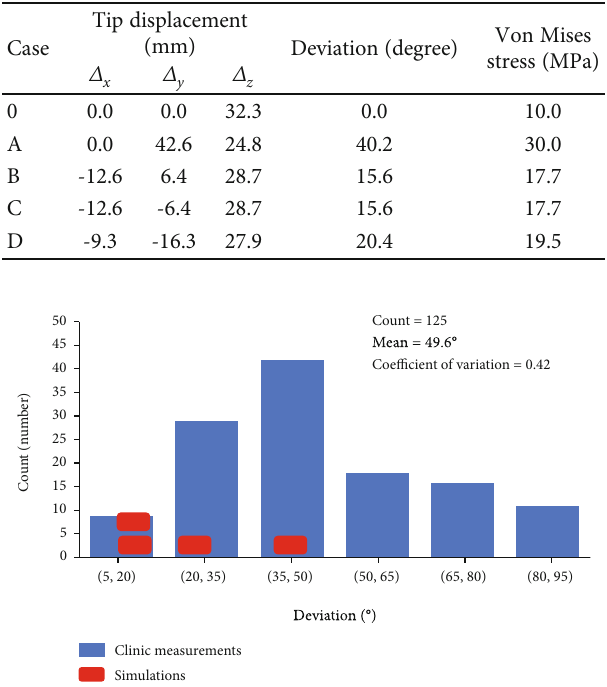
Figure 7: Histogram of penis deviation from the clinical research of Drlik [8].